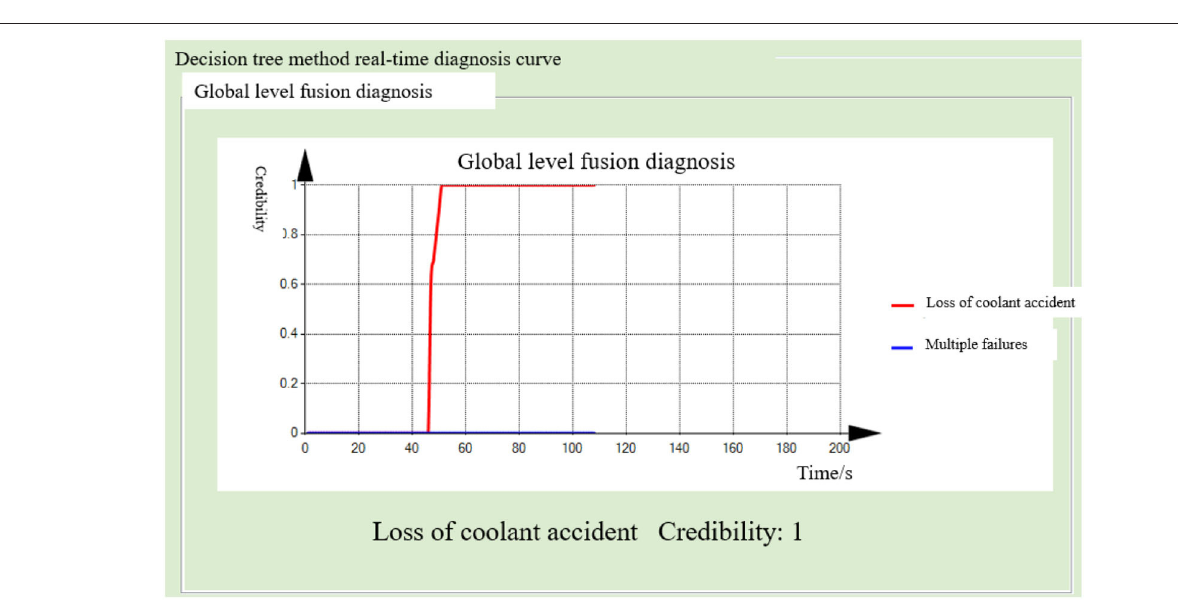
FIGURE 19 | Global-level fusion diagnosis result (decision tree